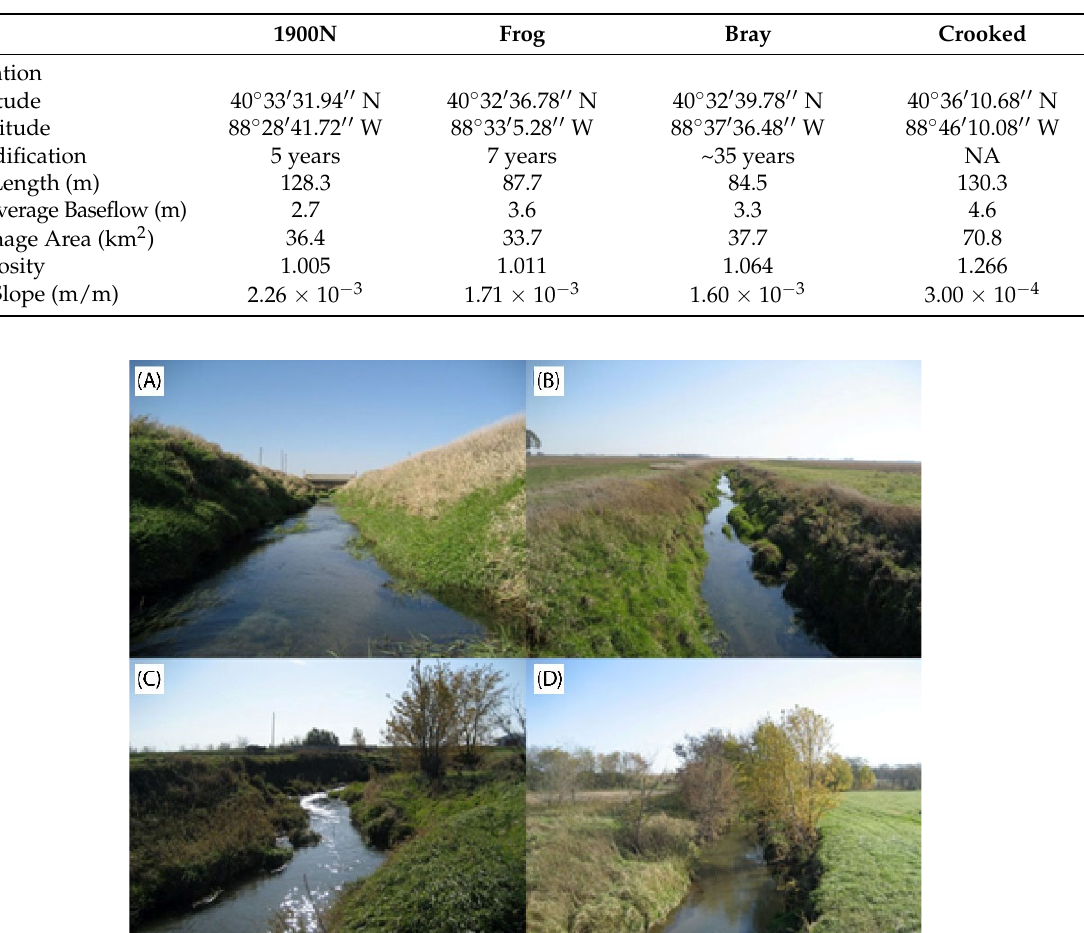
Figure 2. Photographs of the four study reaches. ( A ) 1900N; ( B ) Frog Creek; ( C ) Bray Creek; ( D ) Crooked Creek. 2.2 Methods.